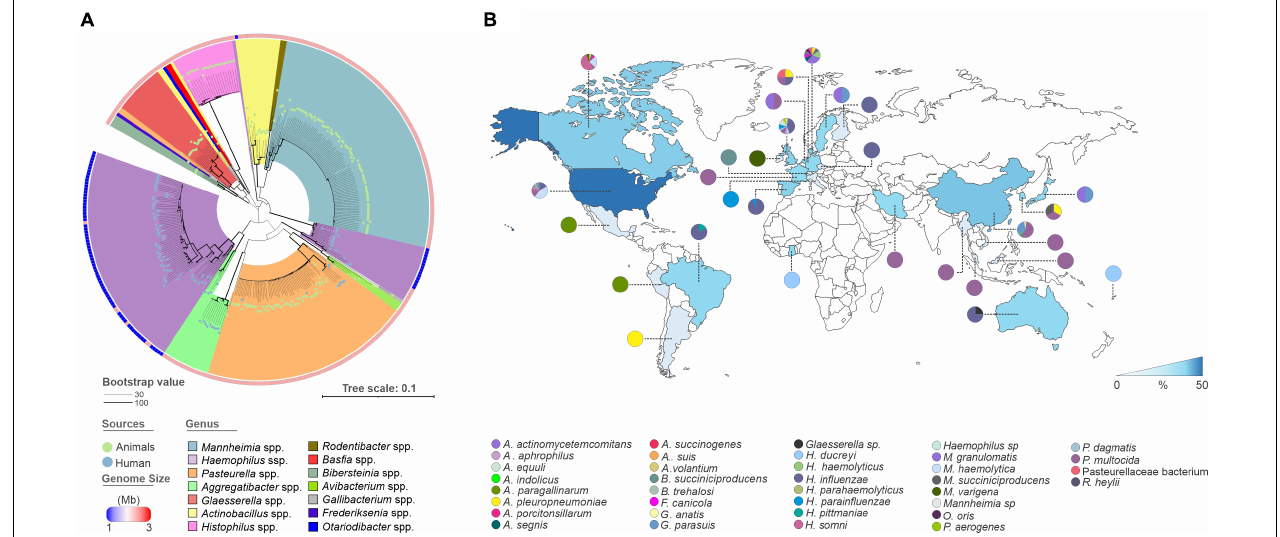
FIGURE 1 | The whole dataset comprises highly diverse and globally widespread genomes. (A) Phylogenetic tree of 16S rRNA genes from 345 complete genomes of Pasteurellaceae species. From the inside to the outside: the 14 main groups according to genus cluster, the size of the genomes (see legend), and the source of each genome (color dots). The evolutionary history was inferred by using the Maximum Likelihood method based on the General Time Reversible model. The tree is drawn to scale, with branch lengths in the same units as those of the evolutionary distances used to infer the phylogenetic tree. (B) Global distribution of publicly available Pasteurellaceae genomes by country. The heatmap below the map was plotted based on the number of genomes among the countries. Species distribution by country is represented by pie charts color-code as indicated in the